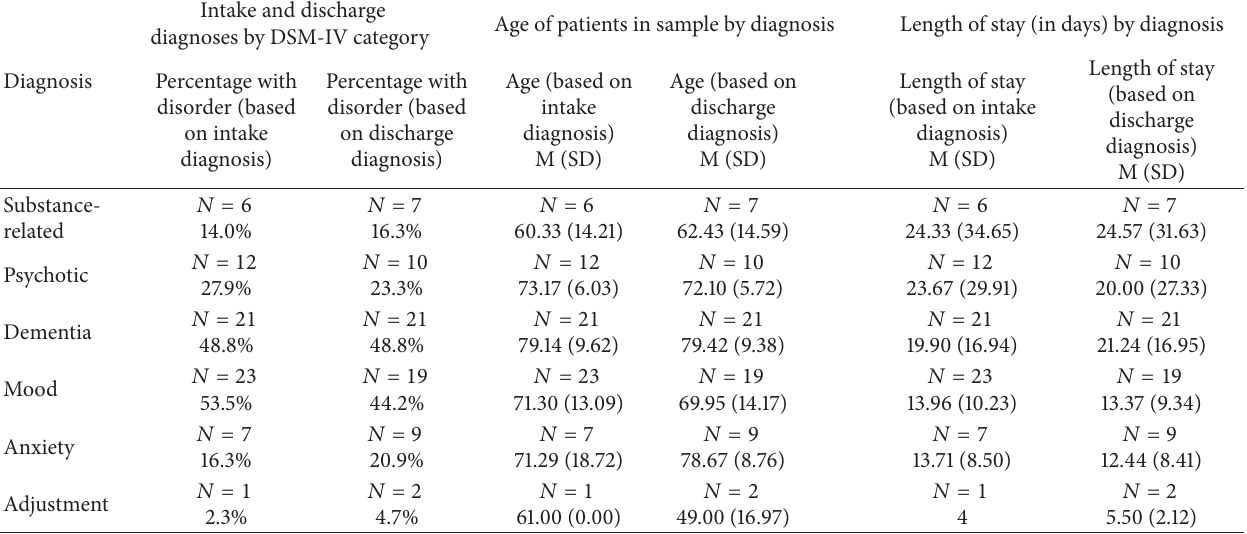
Table 1: Descriptive data for inpatient sample.